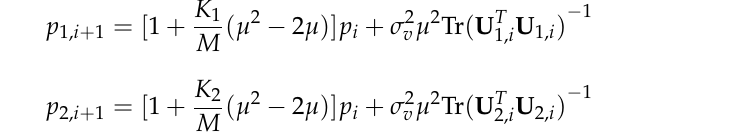
Figure 2. Convergence plots of the current p i and steady-state MSD values (SNR = 30 dB, M = 16, K = 1).